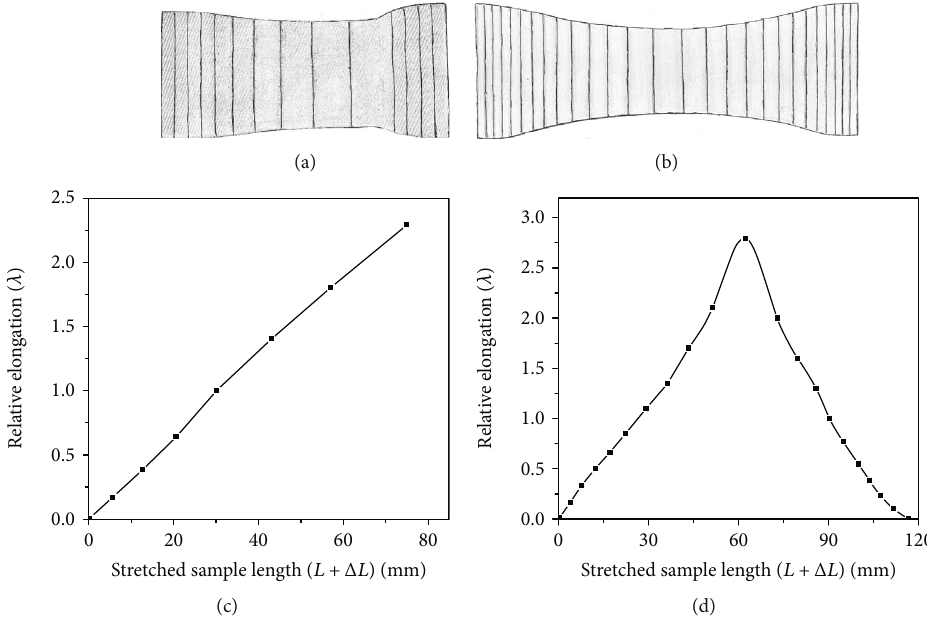
Figure 5: Gradually stretched polyvinyl alcohol fi lms with di ff erent distribution of relative elongation: (a) linear and (b) sinusoidal. (c, d) Dependence of relative elongation λ on the length of gradually oriented fi lms ð L + Δ L Þ presented, respectively, in (a) and